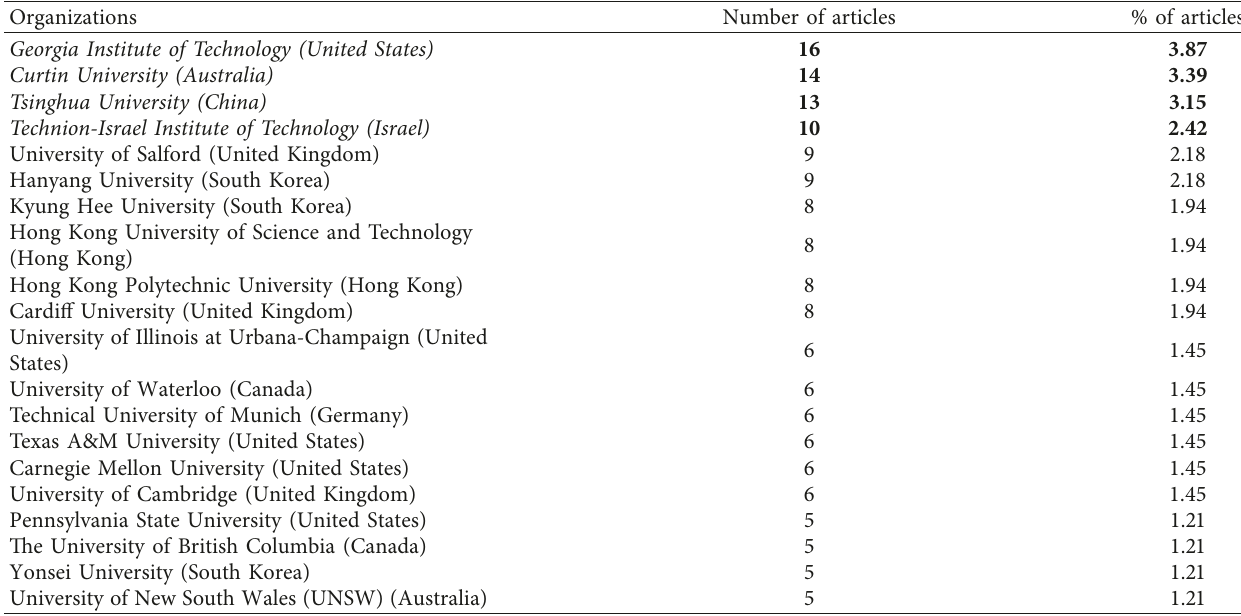
Table 4: The most active organizations, whose number of articles exceeds and equals 5.